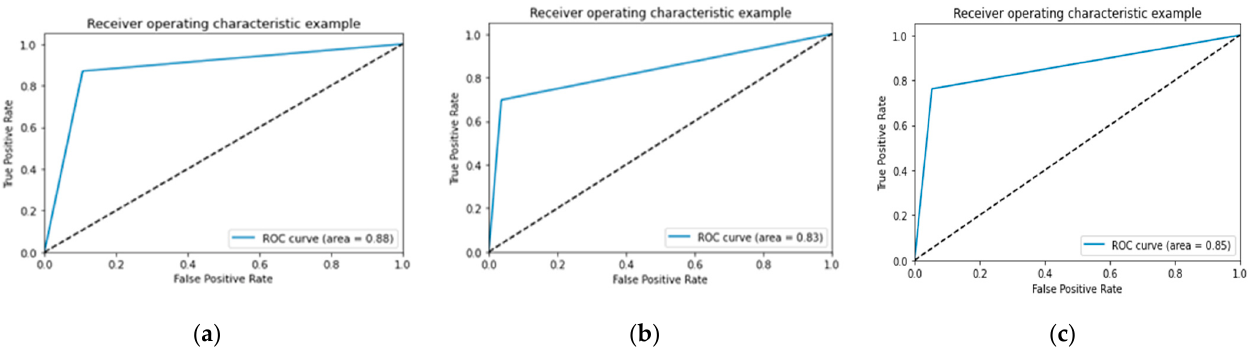
Figure 12. Performance of ROC curve for DenseNet-121: ( a ) infarction; ( b ) ischemia; ( c ) normal.